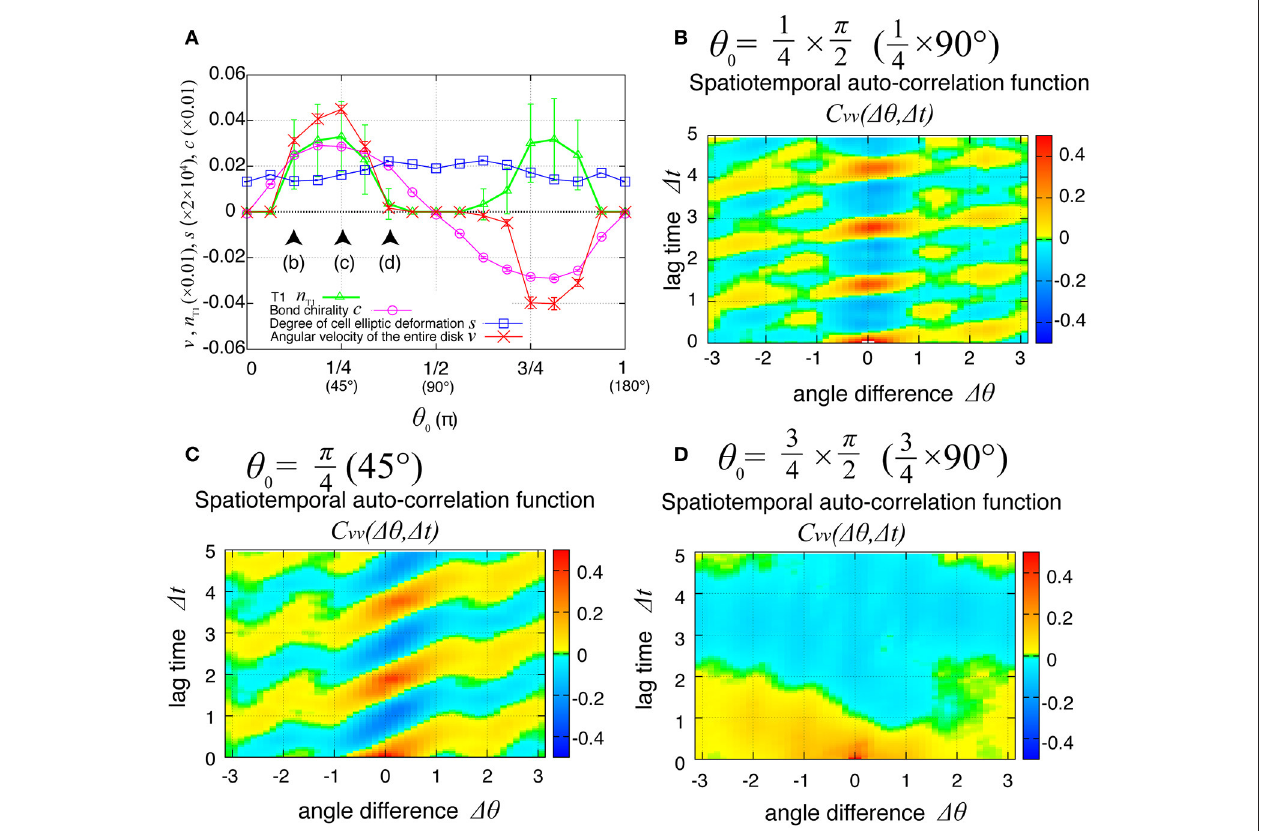
FIGURE 6 | Dependence of collective cell movement on the chirality in the absence of tension fluctuation. (A) Dependence of average quantities on the angle θ 0 in Equation (6): v (red), n T1 (green), s (blue), and c (purple). To calculate the K p -dependence of the angular velocity, the time window from t average. Vertical bars indicate standard deviation in the time course. (B–D) Dependency of spatiotemporal correlation functions of fluctuations in locally averaged cell δ v ( θ , t ) δ v ( θ ∆θ , t ∆ t ) /σ 2 v for K p angular velocity C vv ( ∆θ , ∆ t ) 7.5 in the absence of oscillation of chiral line tension; (B) for θ 0 = h + + i = (D) for θ 0 67.5 ◦ . =